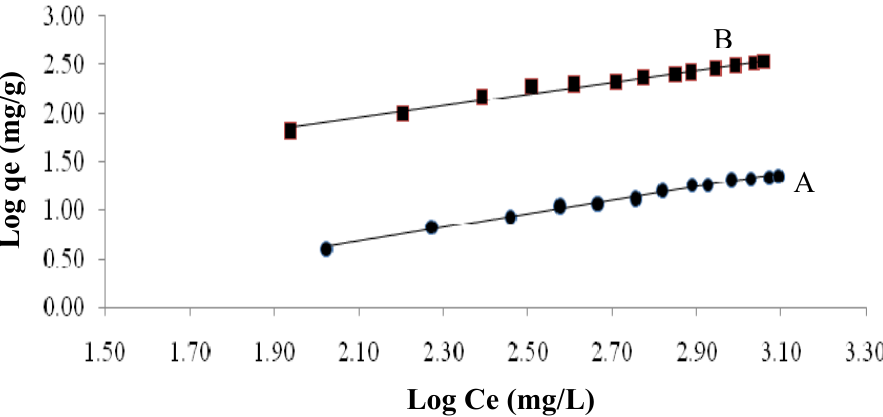
formed: molecules of adsorbate (cadmium) do not deposit on other, already adsorbed, molecules of adsorbate, only on the free surface of the adsorbent. Figure 7. Freundlich biosorption isotherms for cadmium (II) in 0.3 g/L of biosorbent for native (A) and maleic acid-treated Tamrix articulata wastes (B).